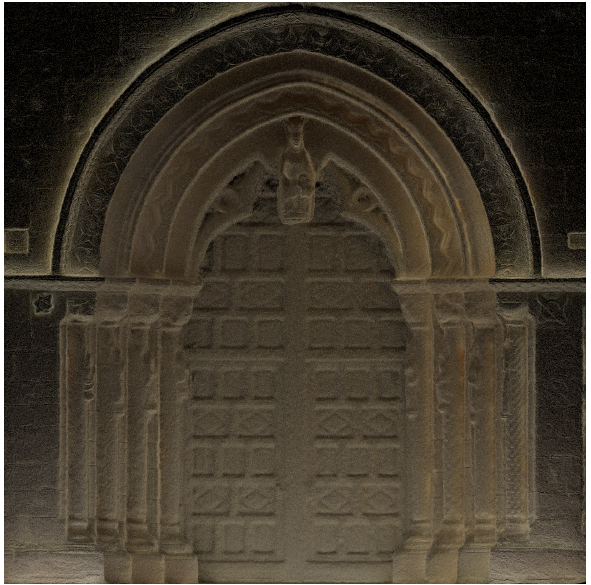
Figure 13: Indirect self-illumination showing the influence of the second bounce of the light in he model, where close surfaces of the own model cast light onto nearby surfaces.